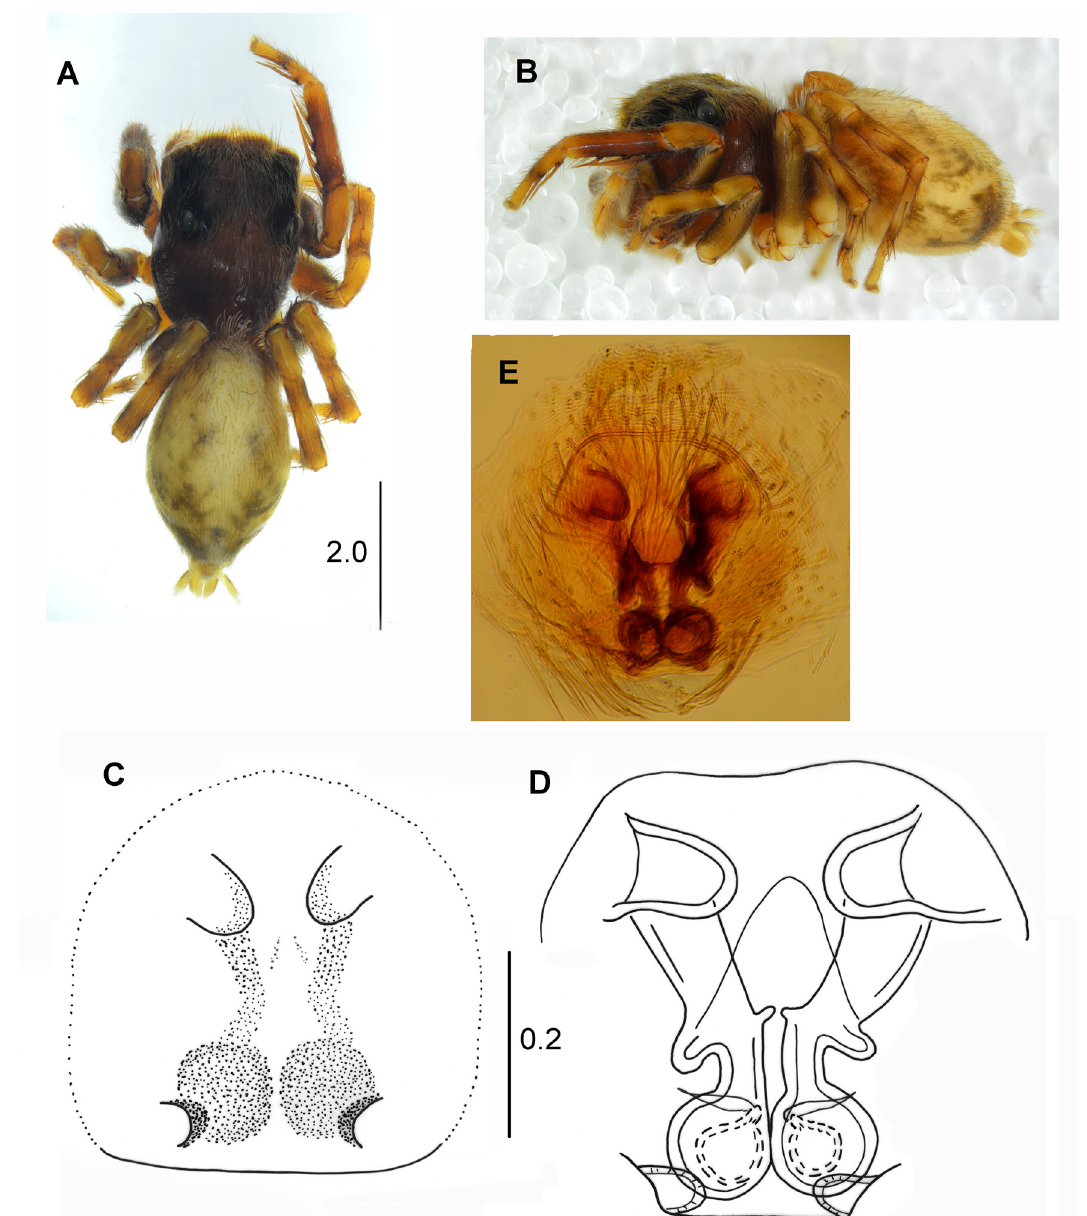
Fig. 52. Pochytoides tonkoui sp. nov., holotype, ♀ (MNHN). A . Habitus, dorsal view. B . Habitus, lateral view. C . Epigyne. D–E . Internal structure of